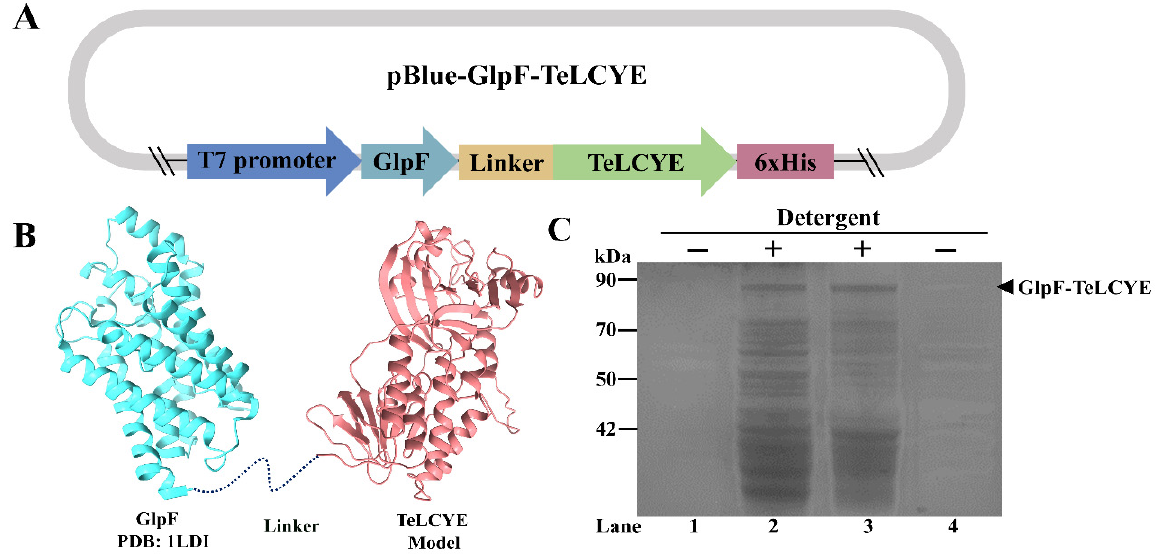
Figure 2. Construction and expression profiles of TeLCYE targeted to E. coli membrane. ( A ) The fusion structure of pBlue- GlpF - TeLCYE expression vector. GGGSGGGS was added as the linker. ( B ) The schematic model of fusion GlpF-TeLCYE. The structural model of TeLCYE was predicted by SWISS-MODEL. ( C ) SDS-PAGE validation for GlpF-TeLCYE expressed in BL21 (DE3). Lane 1, supernatant after cell lysis. Lane 2, detergent solubilized membrane supernatant after ultracentrifugation. Lane 3, detergent solubilized membrane precipitation after ultracentrifugation. Lane 4, membrane collection supernatant after ultracentrifugation.